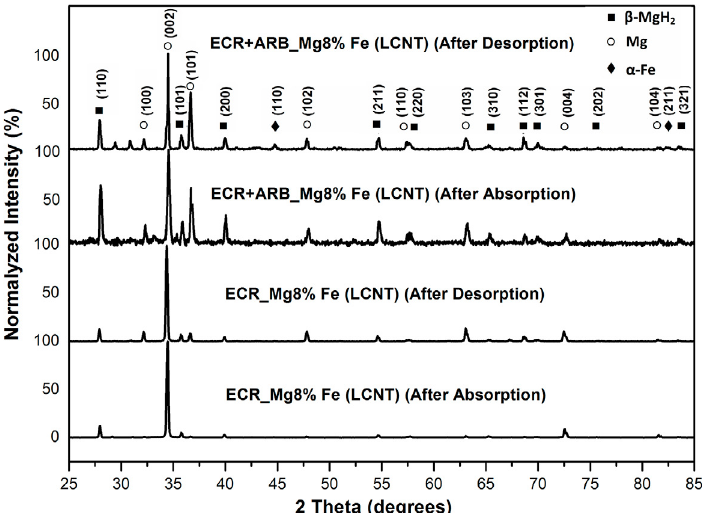
Figure 4. XRD patterns of longitudinal section of Mg-8 mol% Fe samples with LCNT morpholofy after the third cycle of H absorption and desorption, comparing samples 2 processed by ECR and ECR +